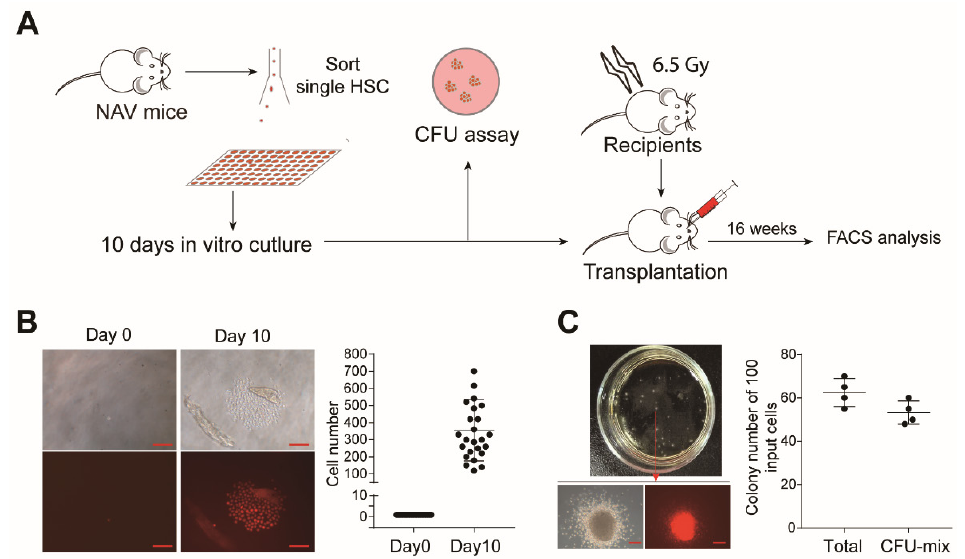
Figure 6. Evaluation of multi-lineage potential by a colony forming assay using 10-day-cultured single NAV HSC. ( A ) Schematic diagram of feeder-free culture of single NAV HSC and subsequent function assessment. ( B ) Colony morphology formed by single NAV HSC after the 10-day culture. Single HSC were sorted into individual 96-wells and cultured in defined feeder-free medium (StemSpan ™ SFEM plus with 100 ng / mL mSCF 20 ng / mL human IL11, β -mercaptoethanol (2000-fold diluted)). Representative images from day 0 and day 10 were shown. The absolute cell number of cells within each colony was counted at day 10, and only colonies with more than 100 cells per well were further analyzed. Scale bars, 200 µ m. ( C ) Colony-forming unit (CFU) assay of in vitro cultured cells. Half of the cells from individual colonies with homogeneous morphology were used as input for the CFU assay. Total CFU and CFU-mix colonies were counted. Scale bars, 200 µm.